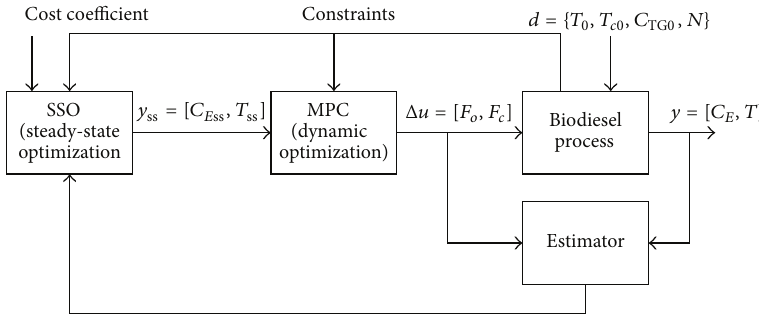
Figure 3: Two-layer predictive framework of biodiesel